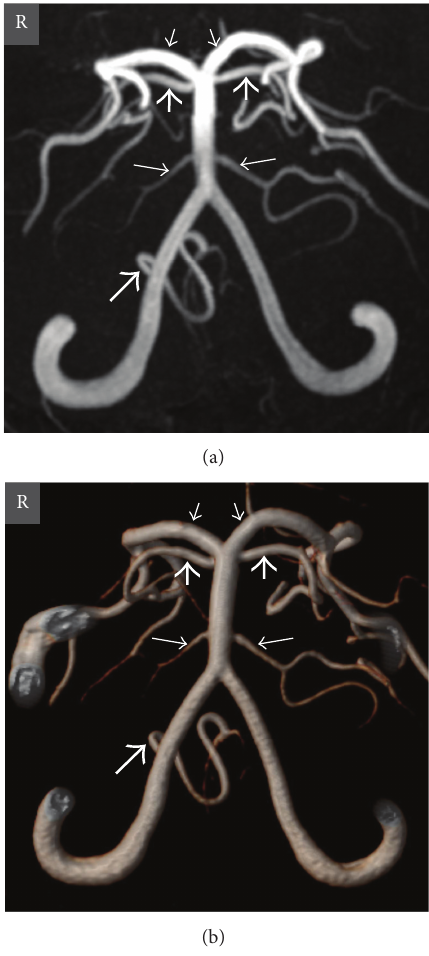
Figure 2: Oblique coronal view MIP (a) and VR (b) TOF MR angiography images show absence of the left PICA, and well- developed left AICA and right PICA in a 12-year-old girl. Thick long arrow = right PICA, thin long arrows = right and left AICAs, thick short arrows = right and left SCAs, thin short arrows = right and left PCAs, and R = right.